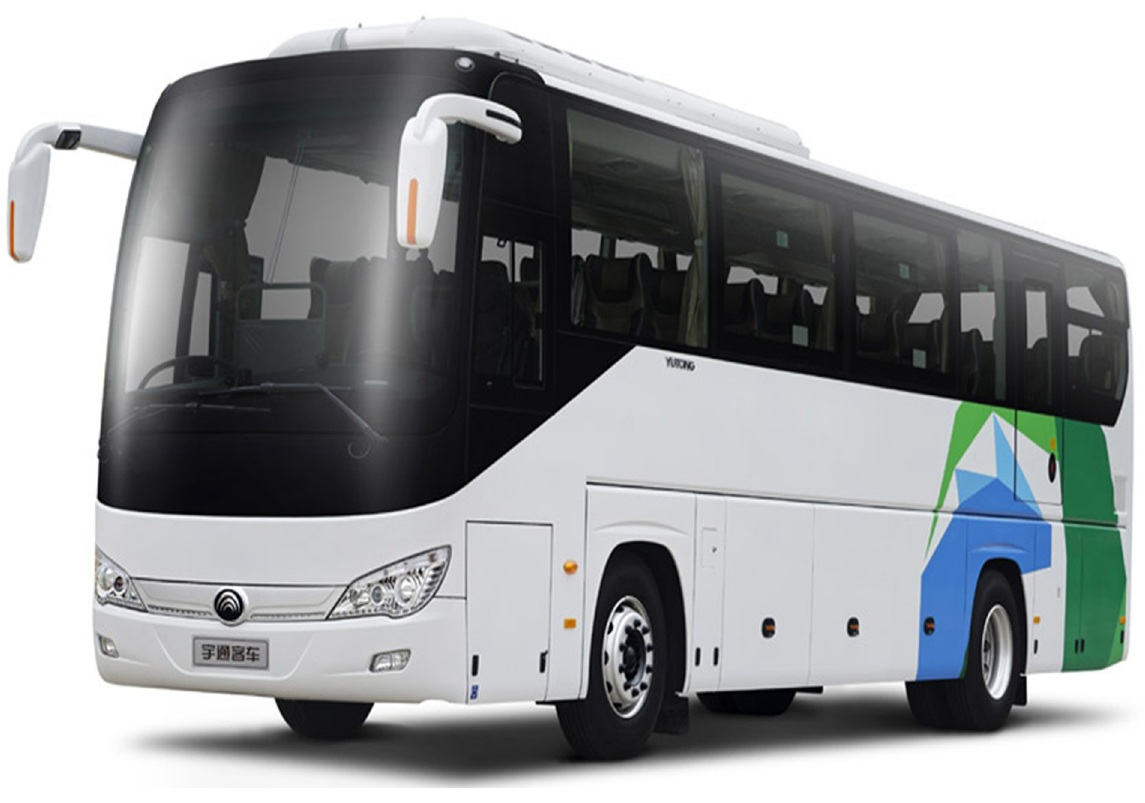
Fig 2. Test leading